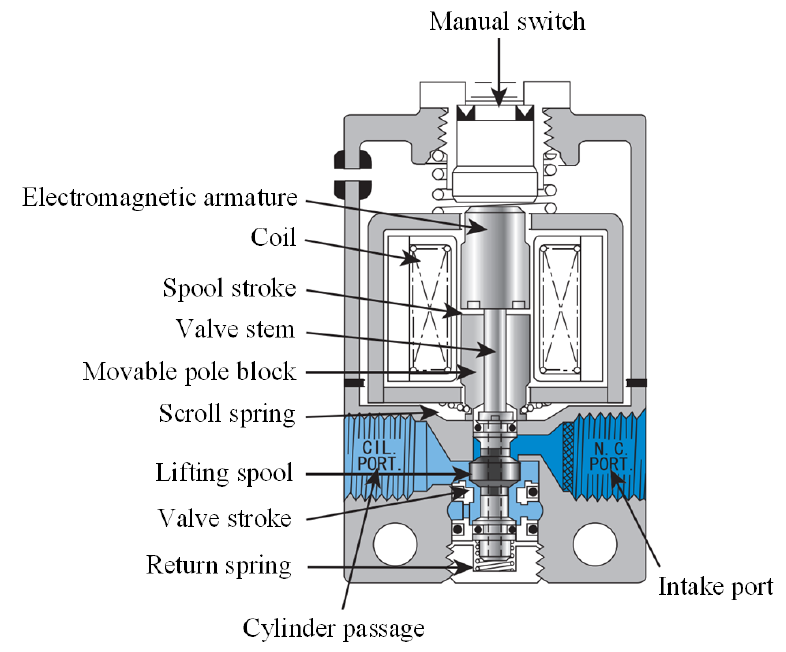
Figure 1. The structure of the high-speed switching solenoid